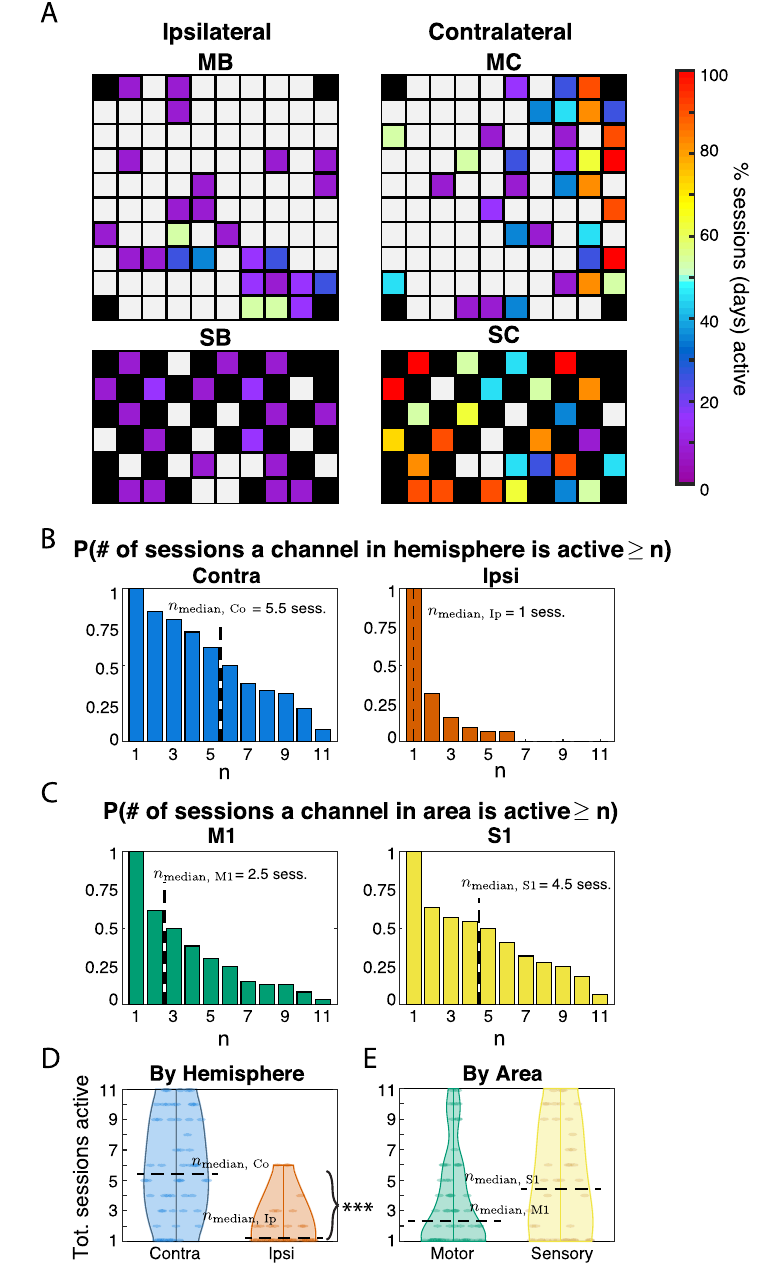
Figure 3. Spatial patterning and longitudinal stability activity from contractions of left wrist extensor (ECR: extensor carpi radialis). Longitudinal stability is considered relative to how often a channel is measured as active relative to the number of experiment sessions (11 total). ( A ) Frequency of activity across sessions for each channel distributed over arrays B and C (top: motor; bottom: sensory). Color code denotes the percentage of sessions (of 11) that a given channel was active, with higher percentages corresponding to greater longitudinal stability. ( B ) Probabilities that any active channel on Pedestals B and C responded for more than n sessions, within contralateral (left panel) and ipsilateral (right) hemispheres. Motor and sensory areas are pooled. Dashed lines mark the median number of sessions responsive among channels within the active footprint of each hemisphere. ( C ) Probabilities that any active channel on Pedestals B and C (mapped in panel A) responds for more than n sessions, measured for motor (left panel) and sensory (right) areas (hemispheres pooled). For example, a channel active for exactly 2 out of 11 possible sessions would be counted in the bars for both n = 1 and n = 2. Dashed lines mark the median number of sessions that a given channel in the active footprint of each area responds. ( D ) Distributions of the number of total sessions a channel responds to attempted left wrist extensions, by hemisphere. The median number of sessions a channel was observed responsive was greater within the contralateral than the ipsilateral hemisphere (n Median, Co –n Median, Ip = 5 sessions; p < 0.001). ( E ) Distributions of the number of total sessions a channel responded to attempted left wrist extensions (among all channels in active footprint), by area. The median number of sessions a channel within the active footprint was observed responsive was greater among sensory than motor arrays (n Median, M1 –n Median, S1 = -2 days, p =